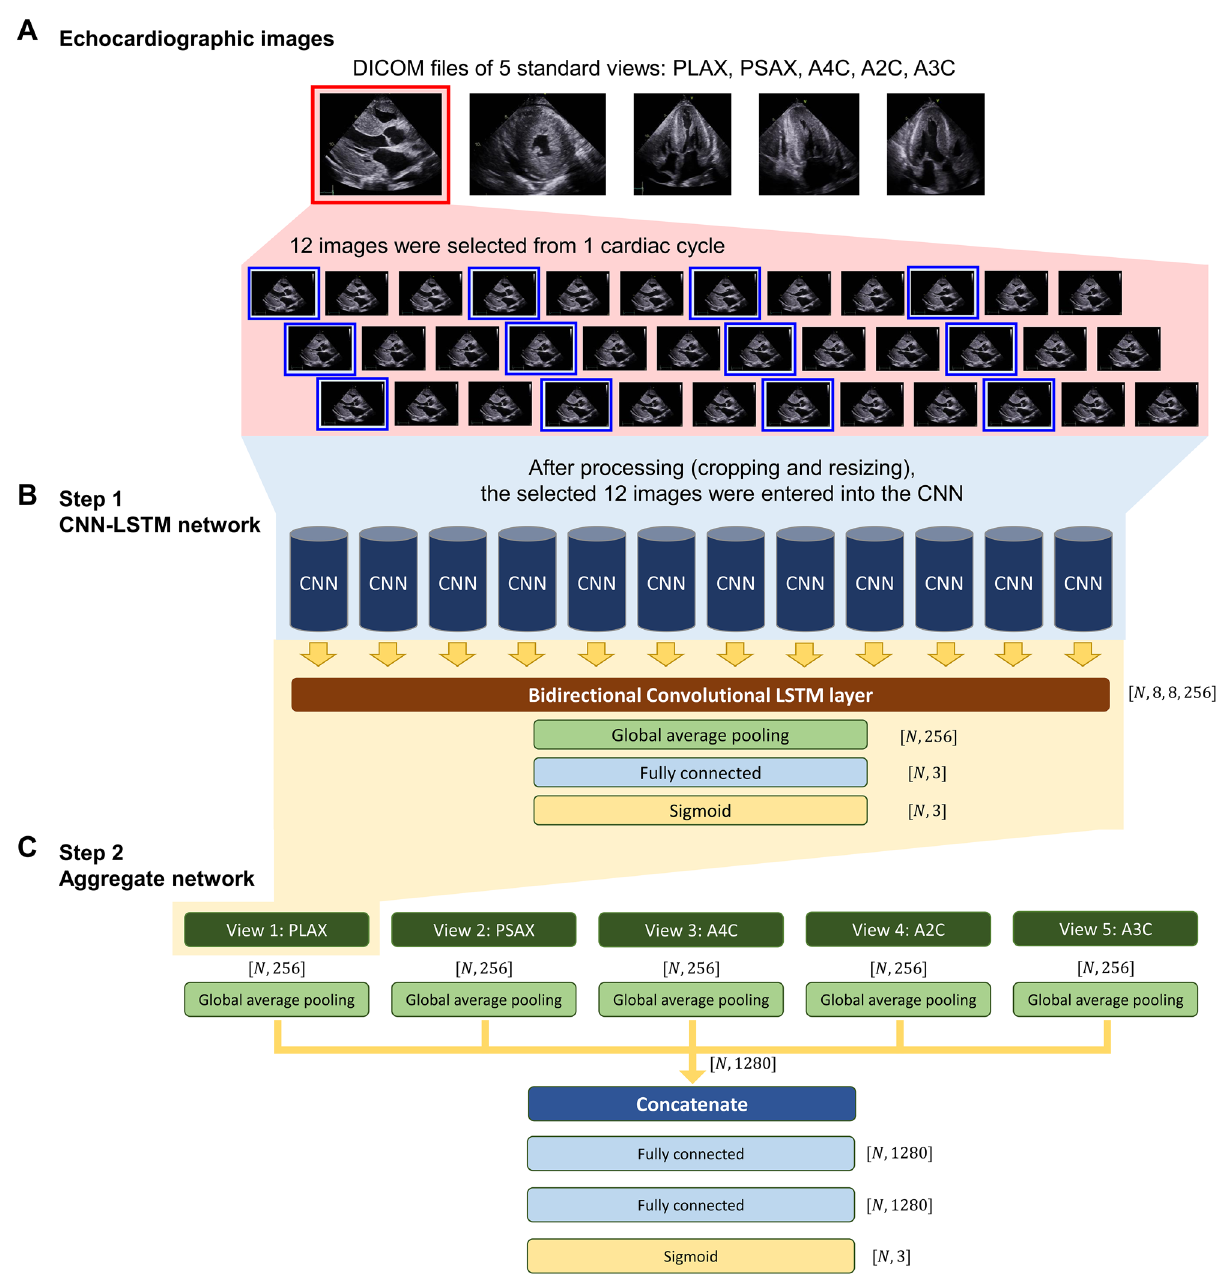
Figure 1. Development of the CNN-LSTM model and aggregate network. Schematic figure depicting the development of the deep learning algorithm. ( A ) Twelve DICOM images were extracted from 1 cardiac cycle at the same time-interval, for each of the 5 standard echocardiographic views. ( B ) In the first step of model development, a CNN-LSTM network was developed for each of the 5 standard echocardiographic views. The same CNN was applied to the 12 echocardiographic images, and a bi-directional convolutional LSTM layer was then applied to these 12 CNNs. A CNN-LSTM network was produced for each of the 5 echocardiographic views. ( C ) In the second step, an aggregate neural network was developed using the outputs obtained from the global average pooling of the multi-label classification block in each of 5 independent CNN-LSTM networks. A2C apical 2-chamber view, A3C apical 3-chamber view, A4C apical 4-chamber view, CNN convolutional neural network, DICOM digital imaging and communications in medicine, LSTM long short-term memory, PLAX parasternal long-axis view, PSAX parasternal short-axis